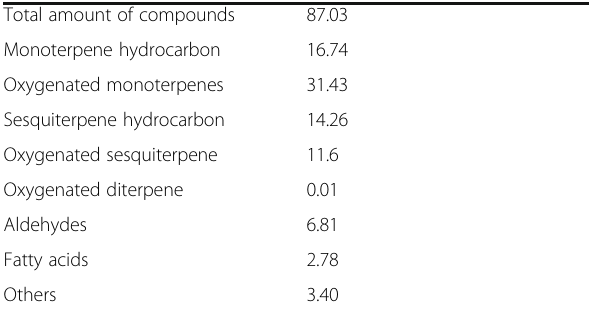
Table 2 Chemical compounds of Cymbopogon validis leaf